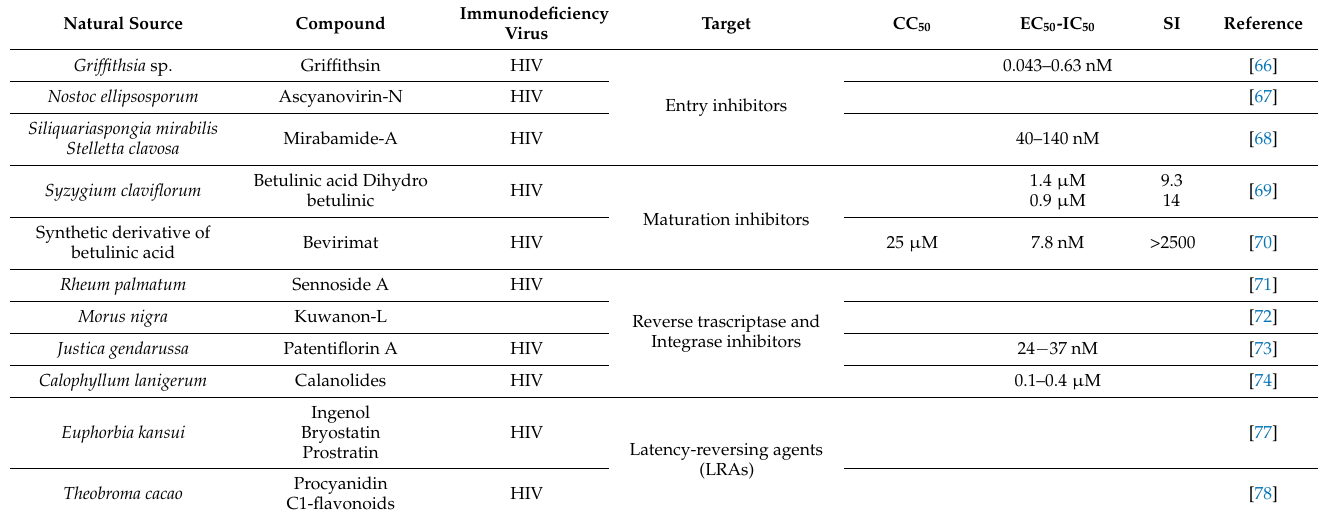
Table 5. Natural compounds and their antiviral targets against Immunodeficiency